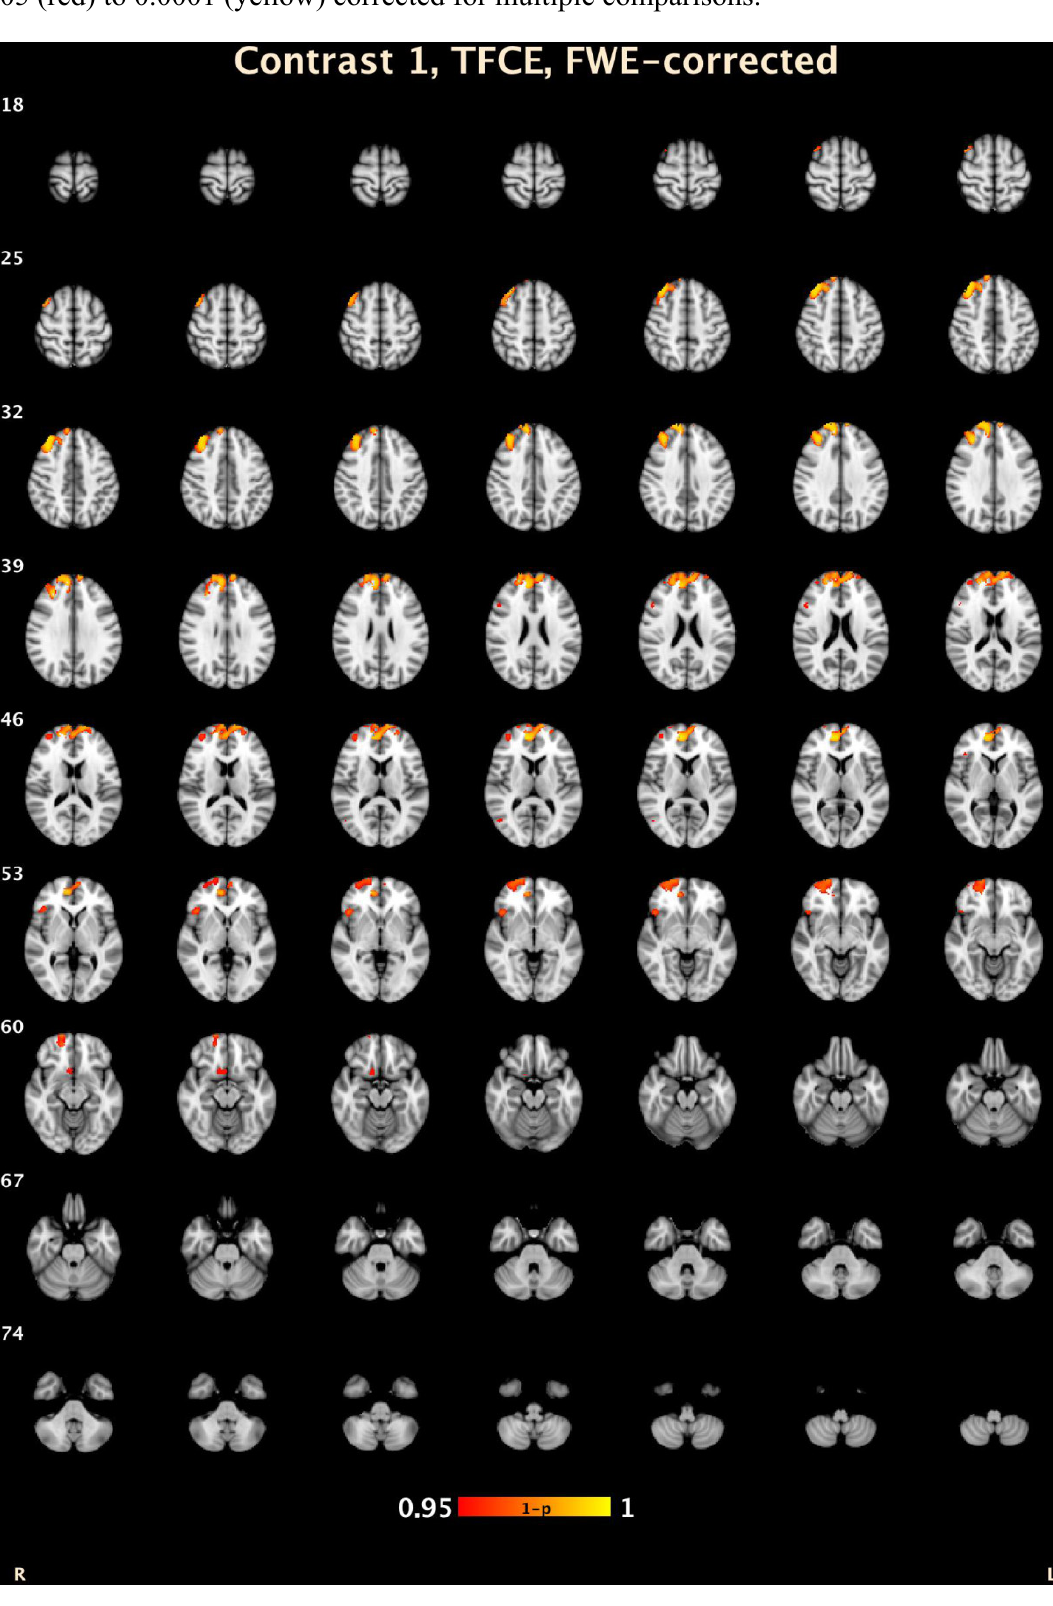
Figure 1. TFCE volumetric differences between CD-BD and HC. 1 − p : Range from 0.05 (red) to 0.0001 (yellow) corrected for multiple